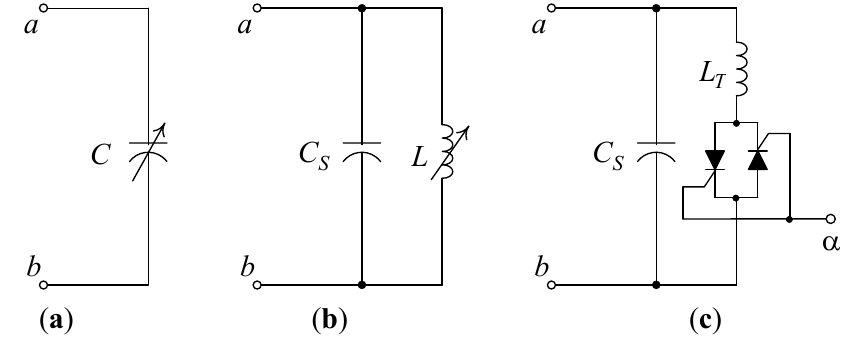
in parallel with a variable inductor L ; ( c ) An SVC S . S